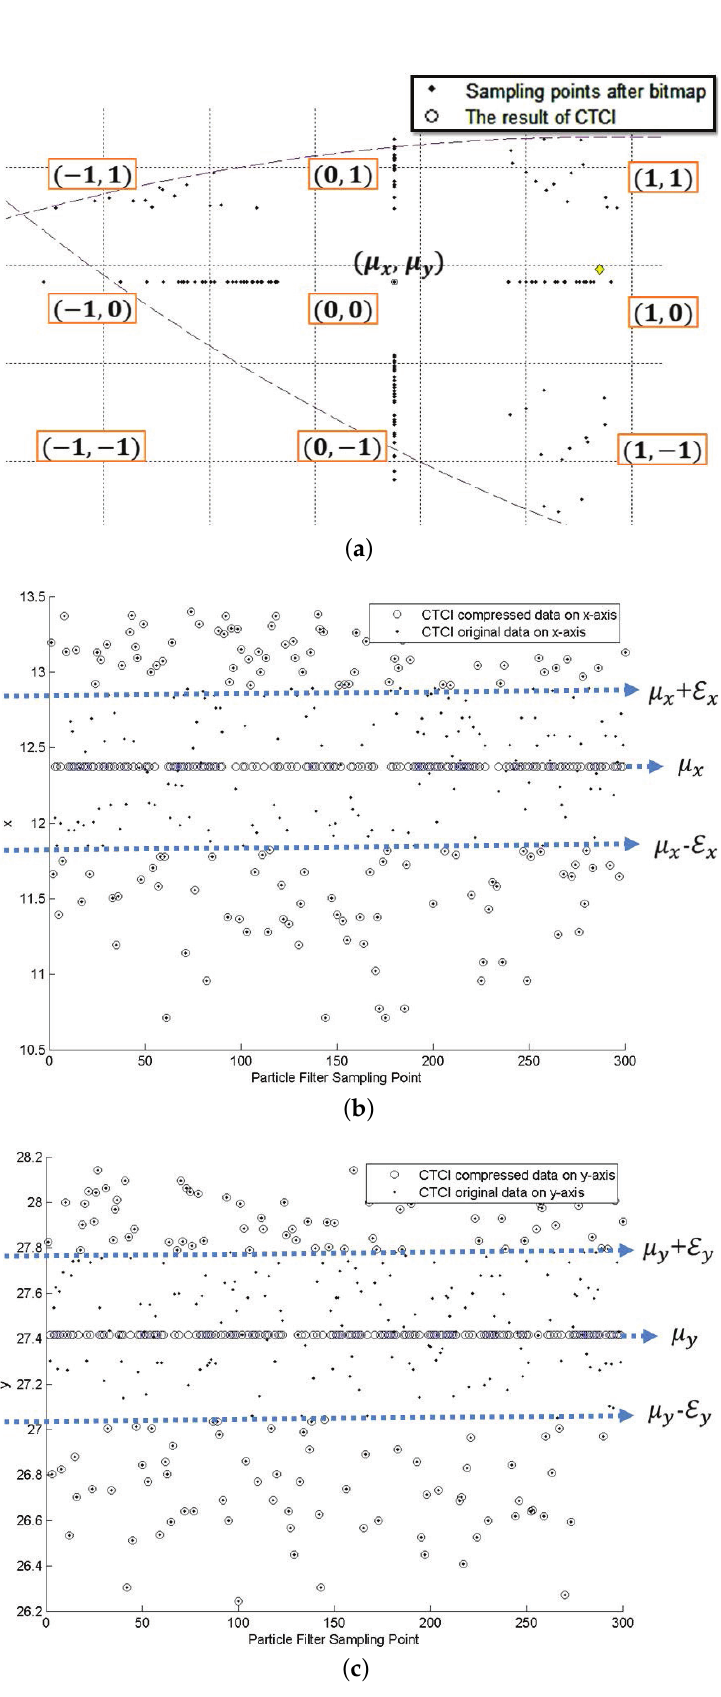
Figure 10. The sampling points after the bitmap process ( a ) and the impact of the compressing bound on distortion: x -axis ( b ) and y -axis ( c